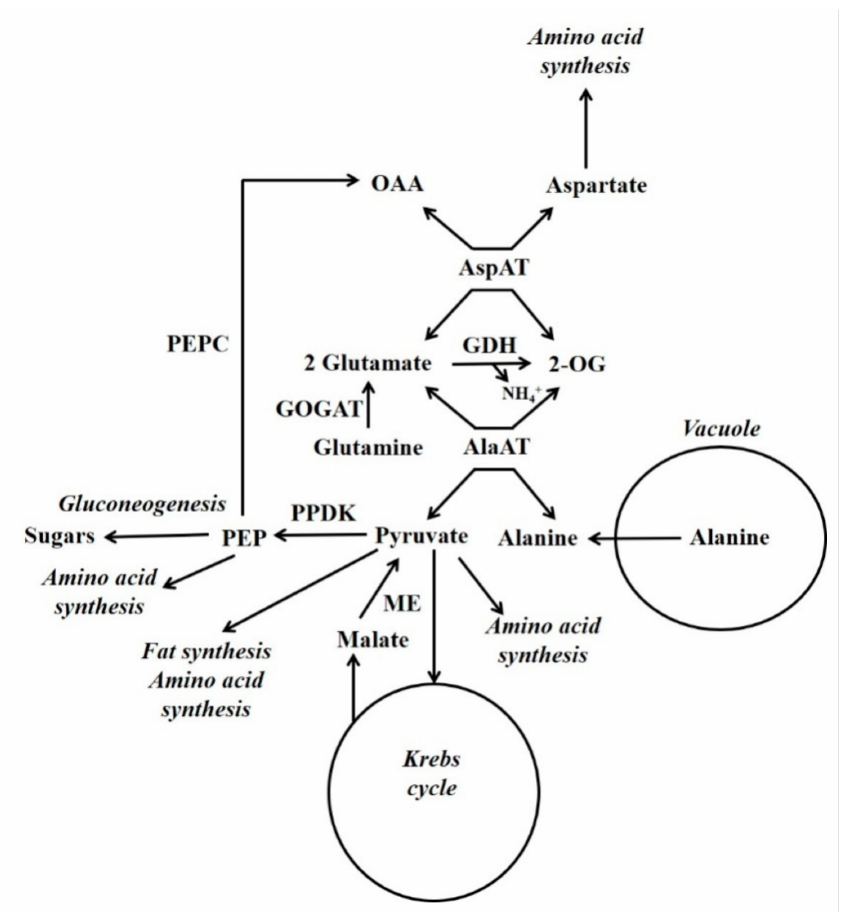
Figure 4. Gluconeogenesis from vacuolar-released alanine. Simplified scheme outlining the func- tions of PPDK in gluconeogenesis and nitrogen metabolism (Reproduced from Walker et al. [7]). GDH = glutamate dehydrogenase; GOGAT = glutamine oxoglutarate aminotransferase; ME = malic enzyme; OAA = oxaloacetate; 2-OG = 2-oxoglutarate; PEP = phosphoenolpyruvate; PEPC = phos- phoenolpyruvate